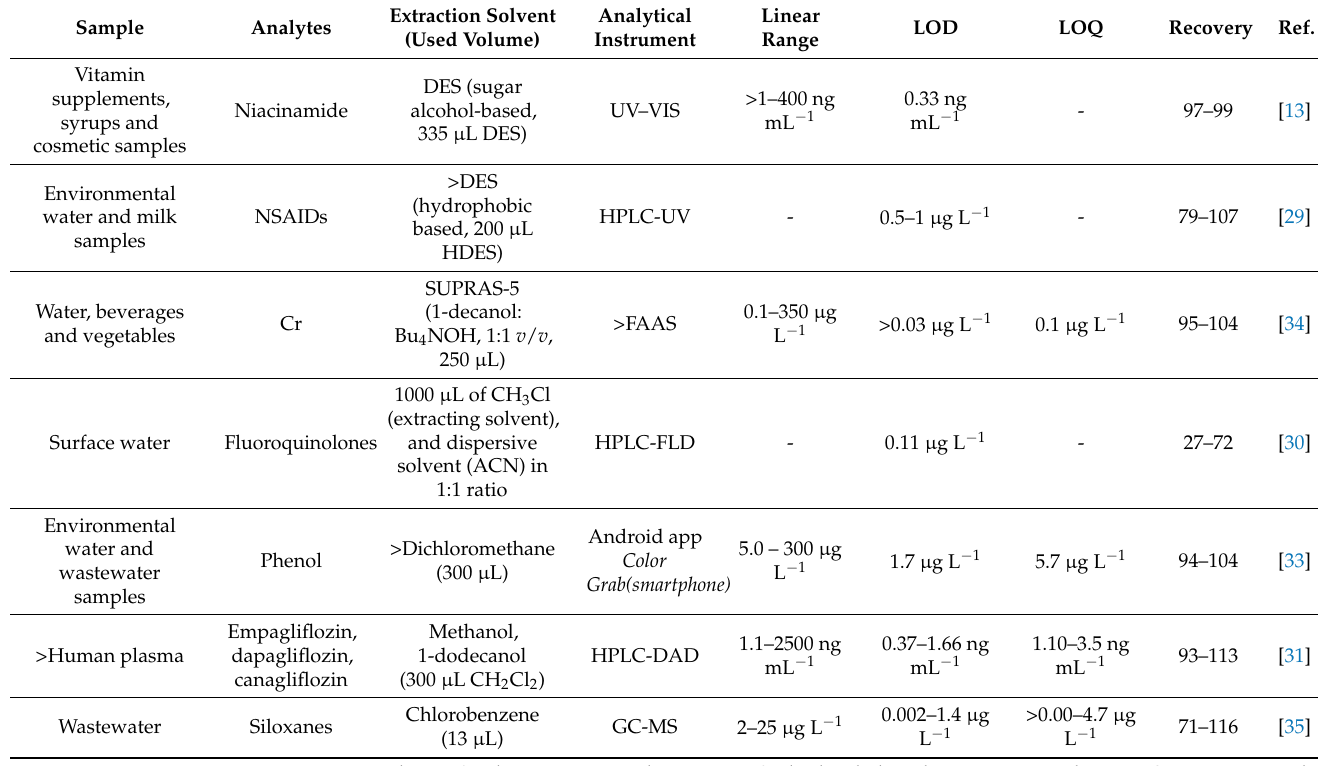
Table 1. The selected DLLME application examples.